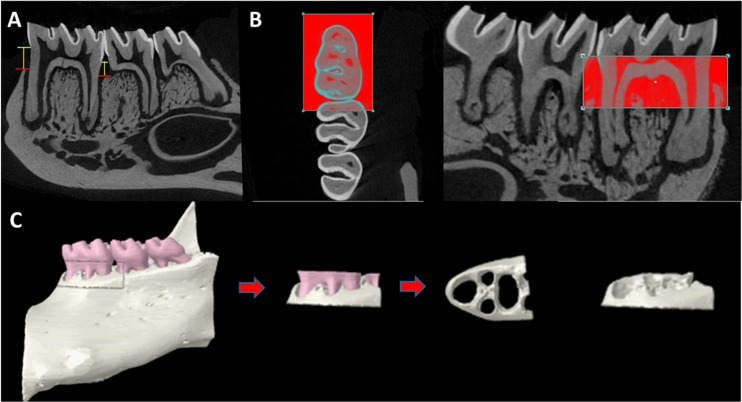
A- Linear measurements are taken of ABL in the interdental space from the CEJ to ABC.(Green line: CEJ, red line: ABC, yellow line: Distance (mm)). B- Axially, a rectangular-shaped region of interest that is 0.33 mm far from each direction of tooth crown. Vertically, a rectangular-shaped region of interest include coronal halves of the slices through mesial root apex to the CEJ. C- Volumetric measurement with 3-D generated ROI.